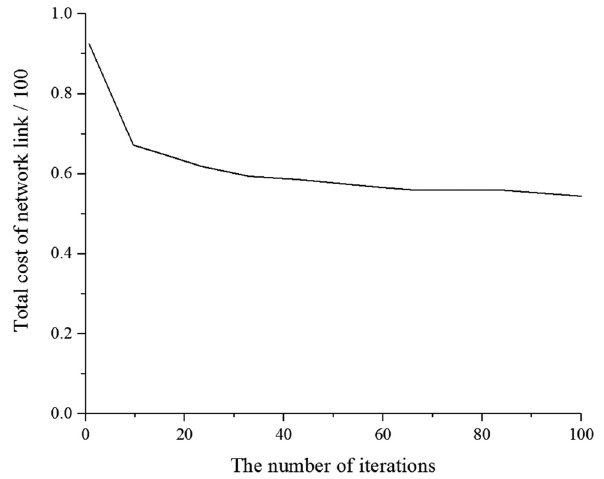
Figure 3: Computer network link cost simulation curve.